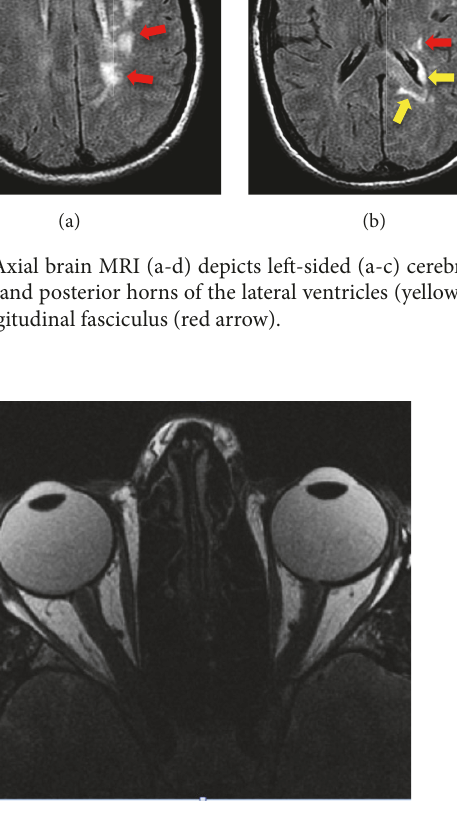
Figure 2: MRI scan of the orbits depicting normal extraocular muscles bilaterally without evidence of fibrosis or